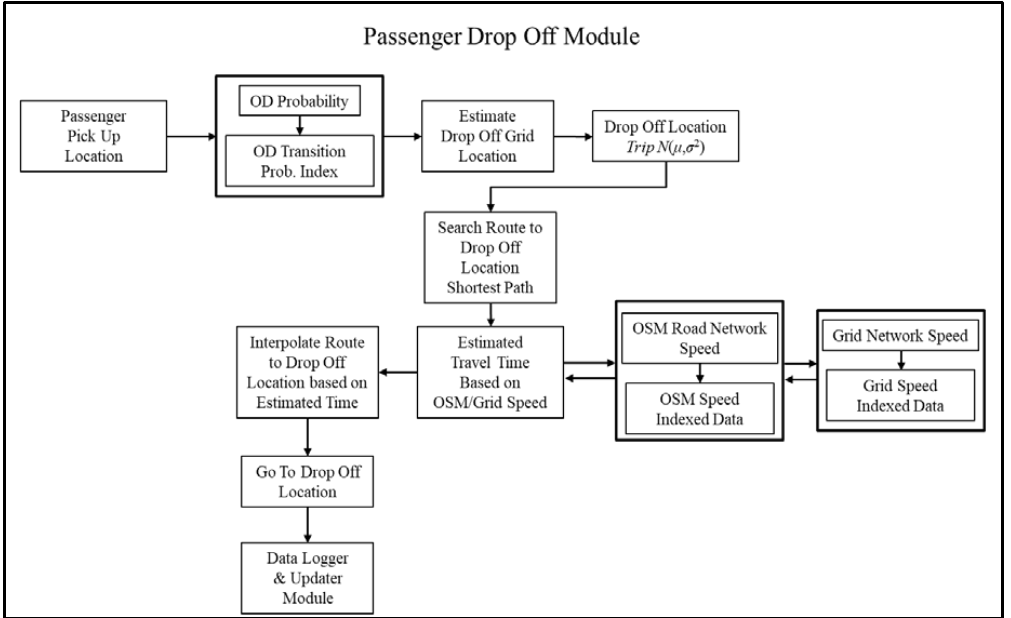
Figure 15. Passenger drop-off module.